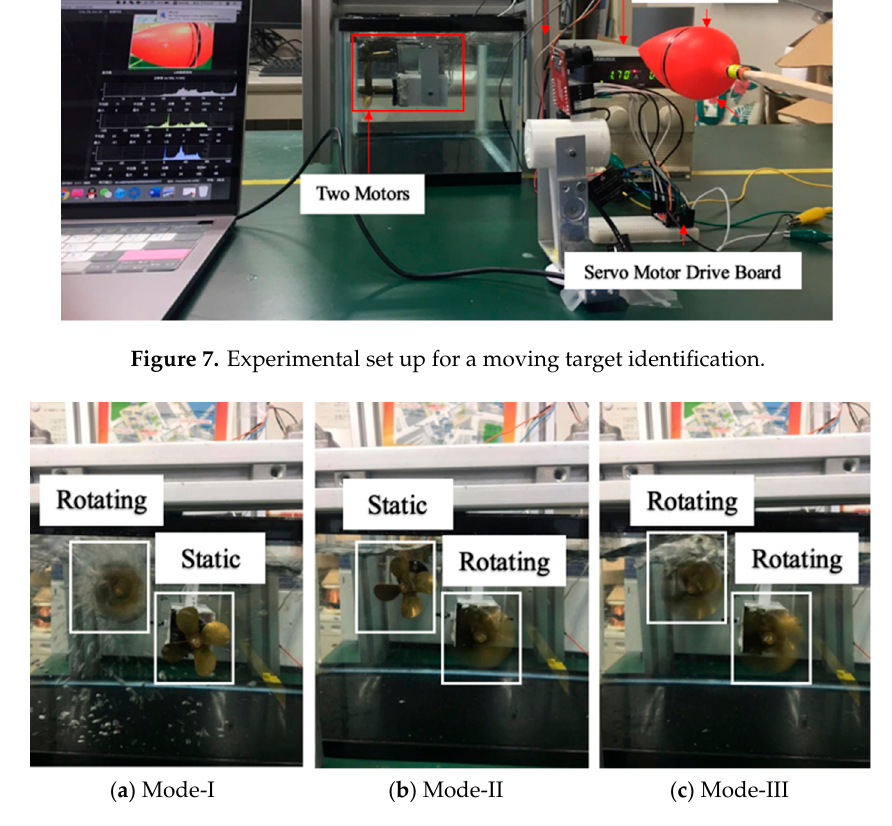
Figure 8. Two control modes of the visual servoing. ( a , b ) Looking for target mode; ( c ) Going forward for target mode.